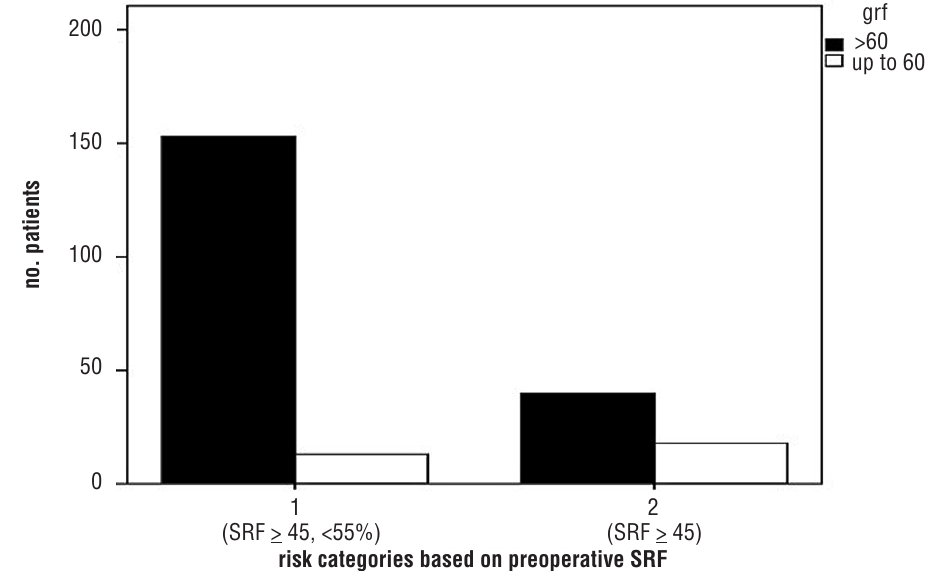
Figure 1 - Bar chart depicting patients stratified into the risk categories based on preoperative Split Renal Function: on the right, risk category 1 (patients with baseline split renal function at renal scan ranging between 45 and 55%); on the left, risk category 2 (patients with baseline split renal function at renal scan < 45%); patients with baseline estimated Glomerular Filtration Rate > 60 mL/min. are represented in the blue bars; patients with baseline estimated Glomerular Filtration Rate ≤ 60 mL/min. are represented in the green bars, 92.2% of patients with baseline split renal function at renal scan ranging between 45 and 55% had Glomerular Filtration Rate > 60 mL/min.